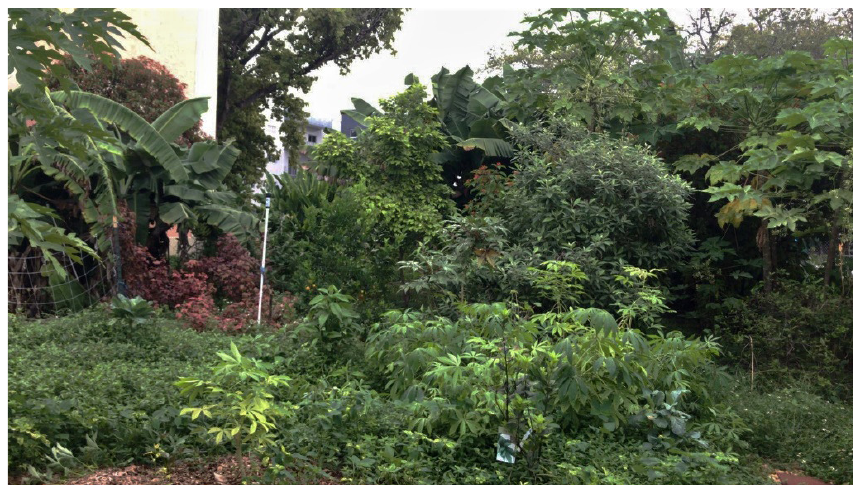
Figure 2. One of the Miami‐Dade County Public Schools’ FF gardens surveyed in this